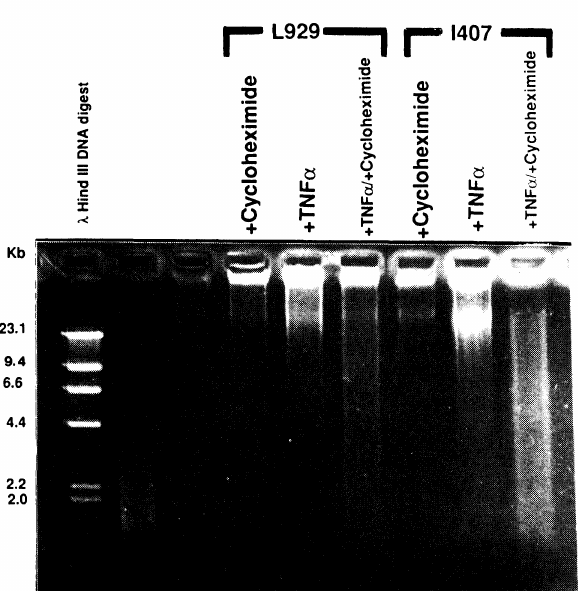
FIG. 3. All cell cultures were confluent. The response of the 1407 and L929 cells to TNF(x is essentially the same, (MTT assays a and c). When the cell lines are cultured with TNF there is almost no change in cell density (apart from the L929 cells which do show a slight decrease in density, Fig. lc). However, when cycloheximide is added to the media, there is a marked decrease in cell density in the cells exposed to TNF, indicative of cell death (p < 0.001 ). (BrdU assays b and d). There is a significant increase in DNA synthesis in those cells cultured in TNF (p < 0.05). When the cultures were repeated with media supplemented with cycloheximide there was marked reduction in DNA synthesis in the 1407 cells (p < 0.01 ). The paired t-test was used to compare the two culturing regimens; medium +TNF( and control medium.